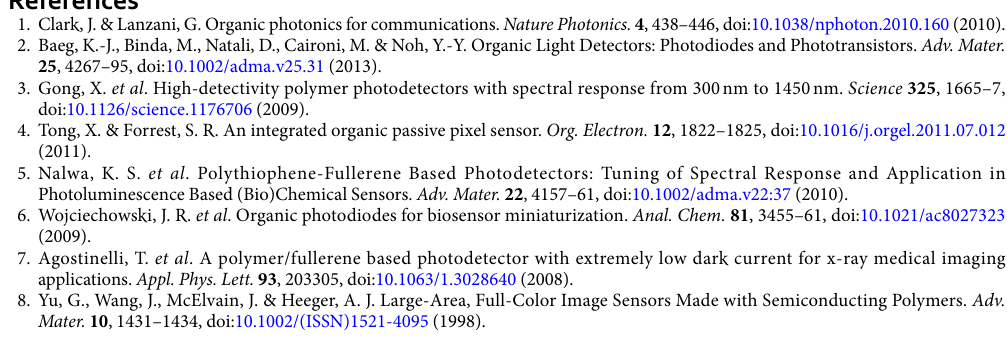
valance band offset (VBO) is not greatly reduced if the value is less than 1, although the conduction band offset is continuously decreased. In our previous study 33 , we reported that if y = 0.92 or less, there is a decrease in the band gap while VBO does not decrease significantly. As more oxygen atoms are added to SiN y , the energy band- gap of SiO x N y increases and the valance band increases more than the conduction band. Therefore, the bandgap tunability and band structure of the SiO x N y layer reduces the dark current and improves the device performance. In summary, we demonstrated the device performance applied to Si-rich SiO x N y film as a buffer layer in an OPDs. Then, external quantum efficiency (EQE) was slightly improved, and the DC and thermal stability were significantly improved, compared with that obtained without the Si-rich SiOxNy buffer layer. These results showed that a Si-rich SiOxNy could be a promising buffer layer for the practical OPD applications. Characterization. The surface roughness of SiO x N y film was about 3 nm by using Atomic Force Microscopy (AFM, Dimension ICON, Bruker, not shown here). All organic layers were thermally evaporated ( < 10 − 7 Torr) at a rate of 1 nm/s. The overlapping area of the two electrodes was 0.04 cm 2 (0.2 cm × 0.2 cm). The device was finally encapsulated with glass. The current-voltage characteristics of the devices were measured by a Keithley K4200 parameter analyzer. The EQE was measured using a setup illuminated by monochromatic light generated by an ozone-free xenon lamp with a chopper frequency of 30 Hz. The monochromatic light intensity was calibrated using a silicon photodiode (Hamamatsu, S1337). Band gap and composition measurements were performed by means of reflection electron energy loss spec- troscopy (REELS) using auger electron spectroscopy (AES, PHI-4700, Concentric hemispherical analyzer) and X-ray photoelectron spectroscopy (XPS, PHI Quantera II Scanning XPS Microprobe), respectively. REELS spec- tra were measured using the primary electron energy of 1,500 eV for excitation and constant analyzer pass energy of 10 eV. The full width at half maximum (FWHM) of the elastic peak was 0.8 eV. Before REELS analysis, samples were subjected to an Ar + ion gun cleaning to eliminate surface contamination.